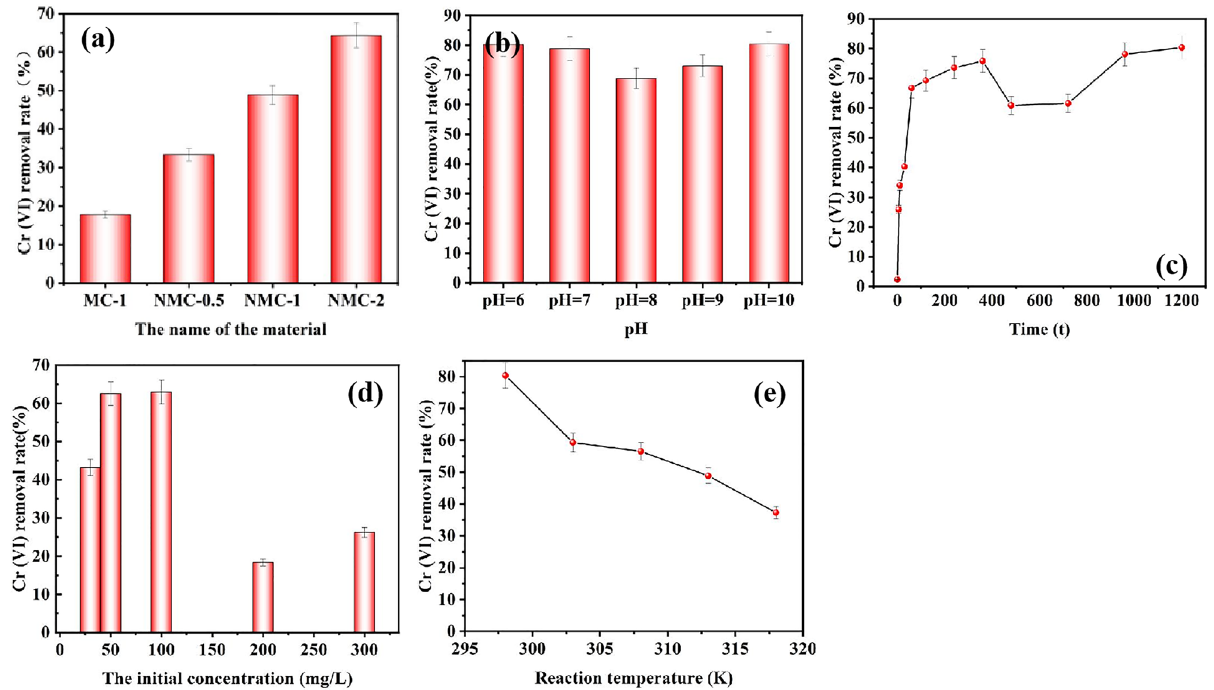
Figure 4. Adsorption influence factor test: ( a ) Effect of Fenton sludge and urea dosage on adsorption efficiency (m = 6 mg, C 0 = 50 mg·L −1 , V = 30 mL, T = 298 K, pH = 8, t = 20 h). ( b ) Effect of pH on Cr(VI) adsorption (m = 6 mg, C 0 = 50 mg·L −1 , V = 30 mL, T = 298 K, pH = 6–10, t = 20 h). ( c ) Effect of time on Cr(VI) adsorptions (m = 6 mg, C 0 = 50 mg·L −1 , V = 30 mL, T = 298 K, pH = 10, t = 0–1200 min). ( d ) Effect of concentration on Cr(VI) adsorption (m = 6 mg, C 0 = 30–300 mg·L −1 , V = 30 mL, T = 298 K, pH = 10, t = 20 h). ( e ) Effect of temperature on Cr(VI) adsorption (m = 6 mg, C 0 = 50 mg·L −1 , V = 30 mL, T = 298-318 K, pH = 10, t = 20